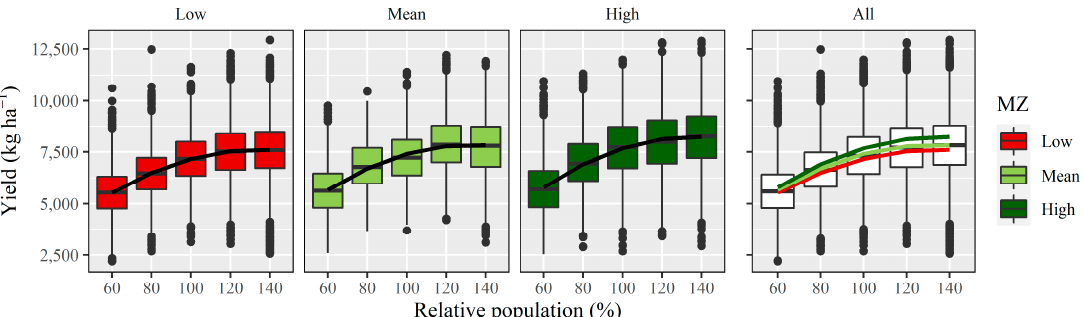
Figure 8. Relationship between maize yield and its relative population in the second crop harvest for each of the three management